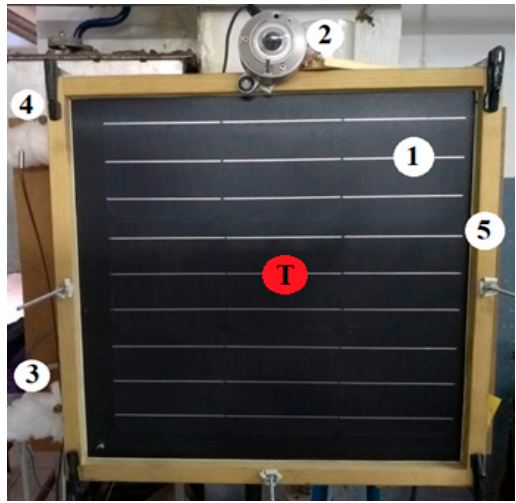
Figure 4. The PV roof tile with the casing and the solarimeter. 1: The PV roof tile; 2 : the solarimeter; 3 : the air inlet; 4 : the air outlet; 5 : the wooden frame; T : the location of the temperature measurement.